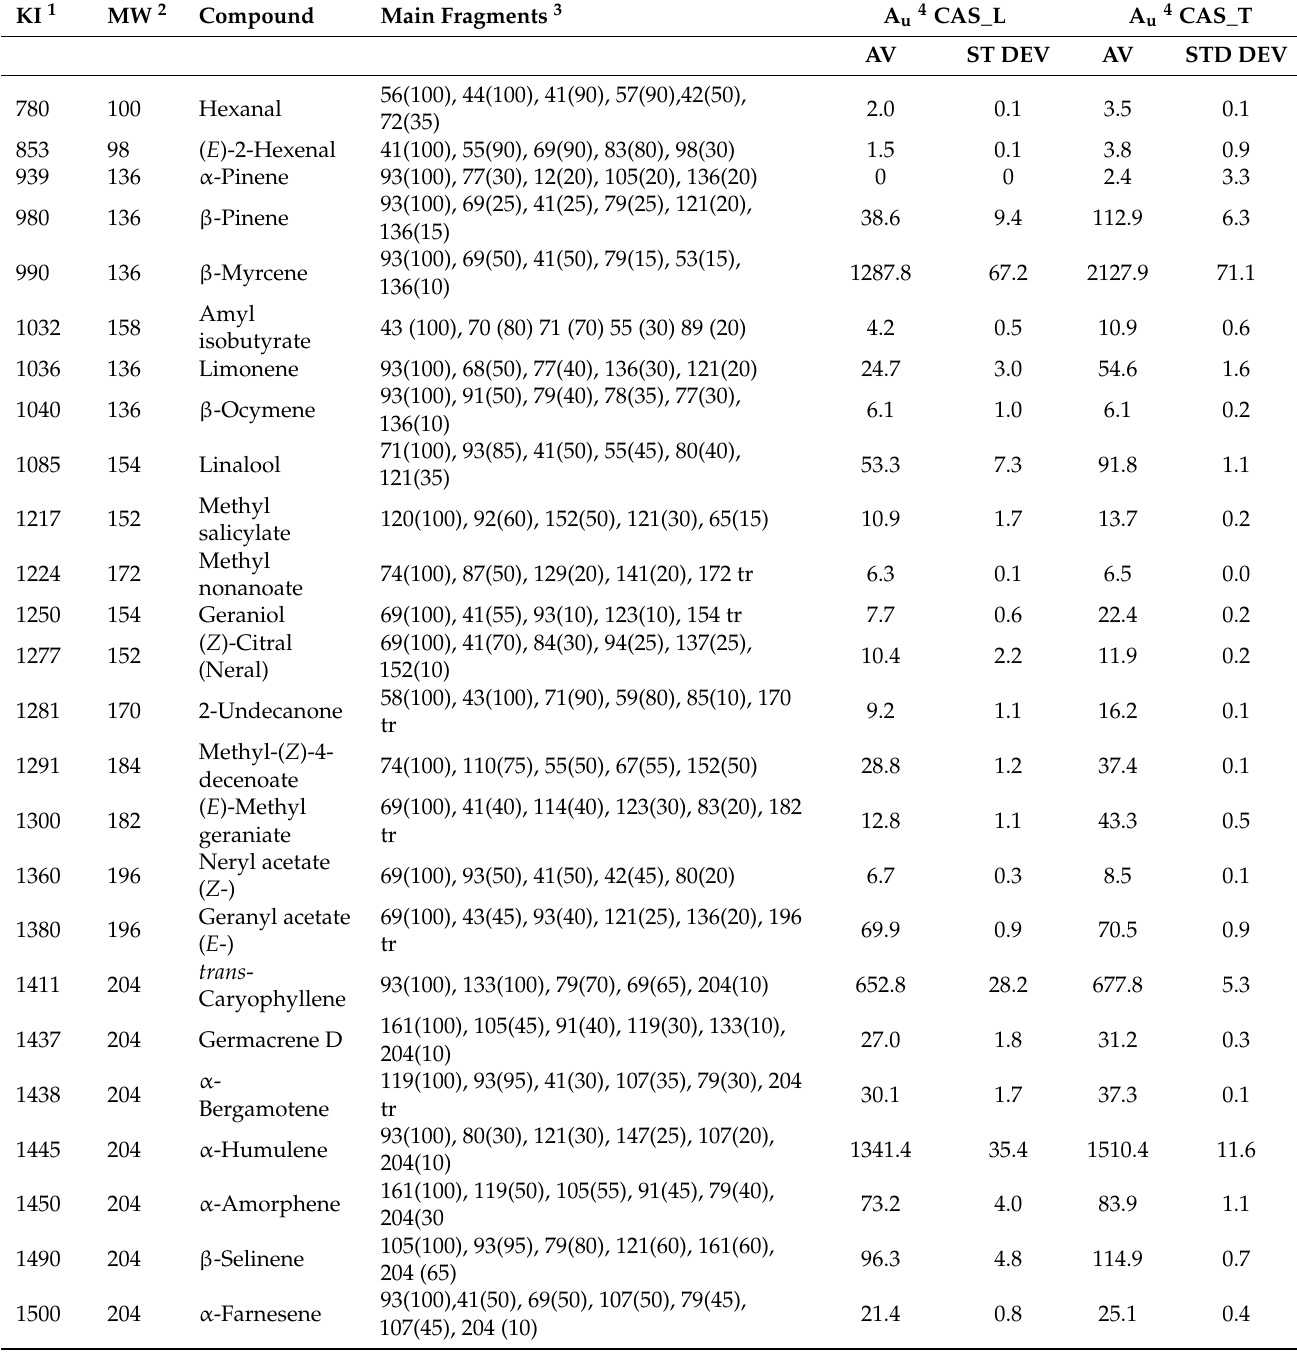
Table 3. Compounds identified by GC-MS in CAS_T and CAS_L hop